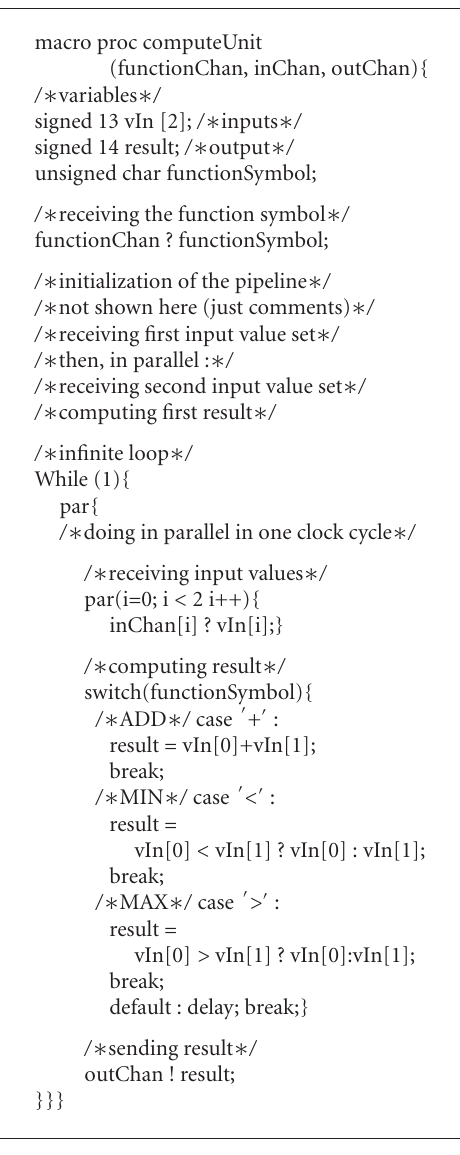
Algorithm 2: Typical code example for a compute node